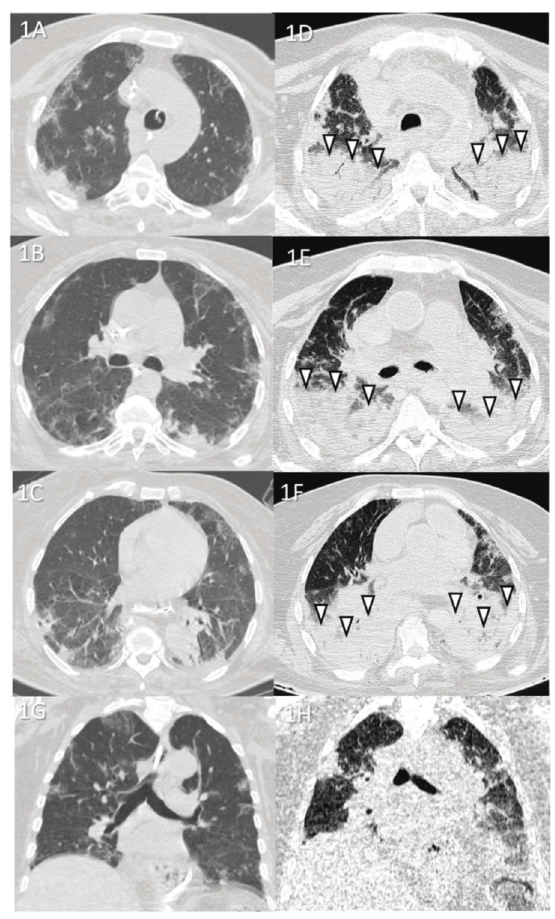
Figure 1 - Case 1: Premortem axial chest computed tomography (CT) of the upper (A), mid (B), and inferior (C) thirds of the lungs obtained 2 days before death showing peripheral ground-glass opacities, slight consolidations, and interlobular septal thicken- ing. Postmortem axial chest CT of the upper (E), mid (F), and inferior (G) thirds of the lungs obtained 4 h 47 min after death showing opacities larger than those on premortem CT, thus demonstrating the progression of the disease until death. Postmortem posterior ‘‘ horizontal level forming ’’ consolidations because of hypostasis (white arrowheads) are also observed, which limited analysis of the posterior lungs in this case (limi- tation of the method). Images D and H show pre- and post- mortem coronal reformats, respectively.